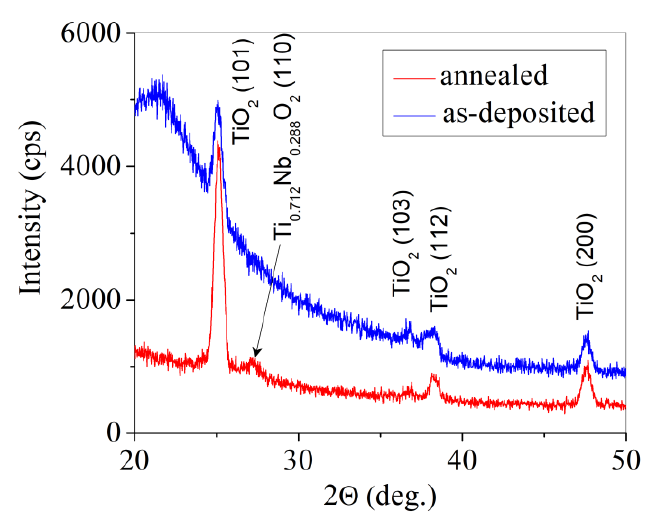
Figure 2. XRD patterns of the Ti 0.72 Nb 0.28 O 2 film before (dark line) and after annealing in H 2 atmosphere (red line).